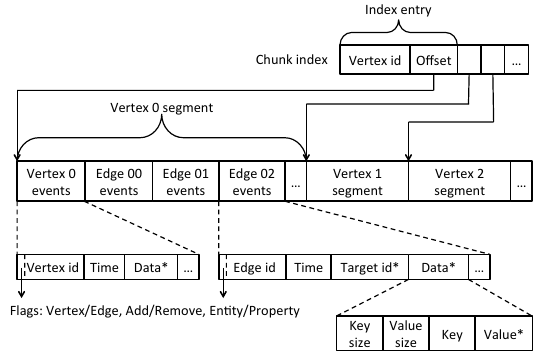
Fig. 5 The physical layout of an unsealed chunk. The log buffer (in gray) has no